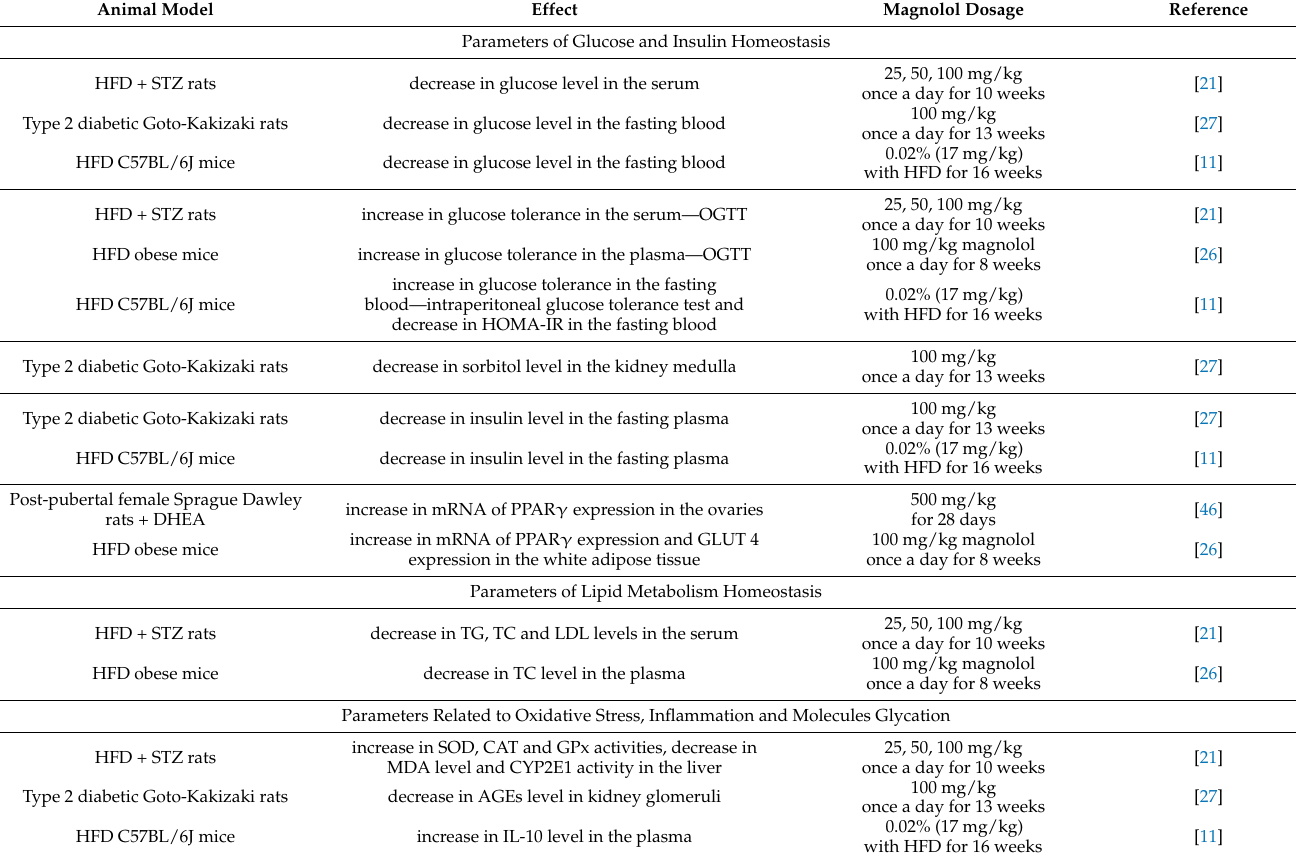
Table 2. Antidiabetic activity and the effect of magnolol on the basic parameters of oxidative stress and lipids in in vivo